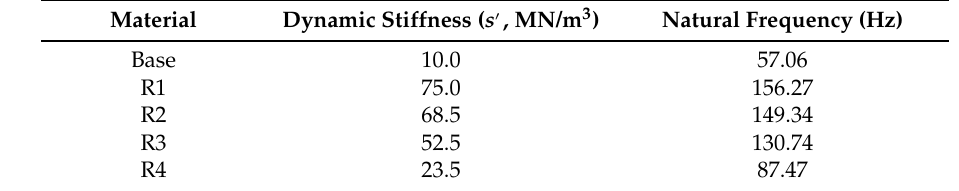
Table 12. Natural frequency of resilient